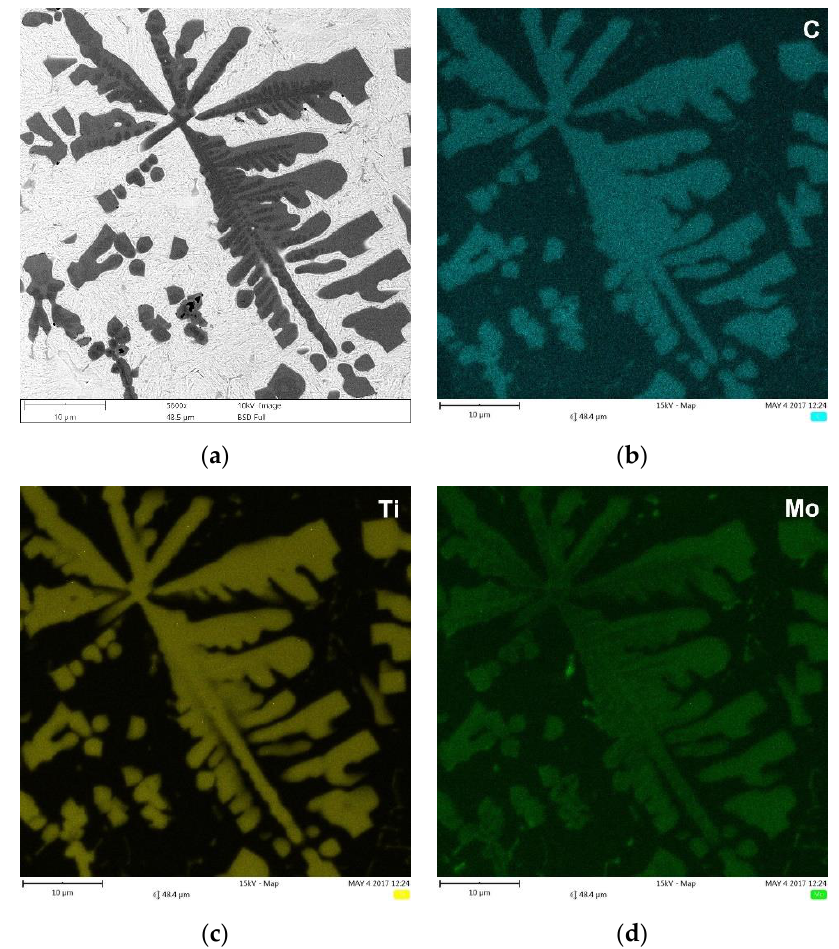
Figure 10. ( a ) BSE SEM micrograph taken from the mid-section of the TRM (Table 3), showing the primary (Ti, Mo)C precipitates in dendritic form and eutectic plate-like (Ti, Mo) C precipitates, and ( b – d ) corresponding distribution maps of C, Ti, and Mo, respectively.